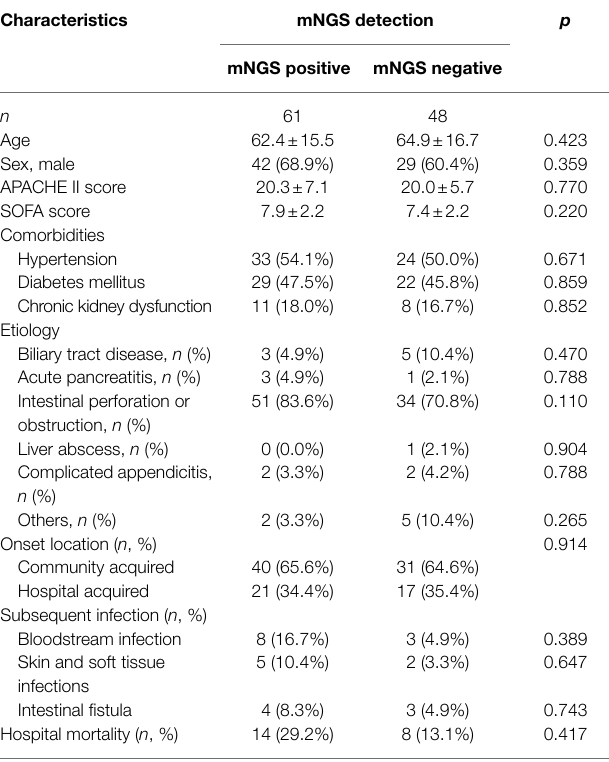
TABLE 1 | Demographic and clinical characteristics of study patients.